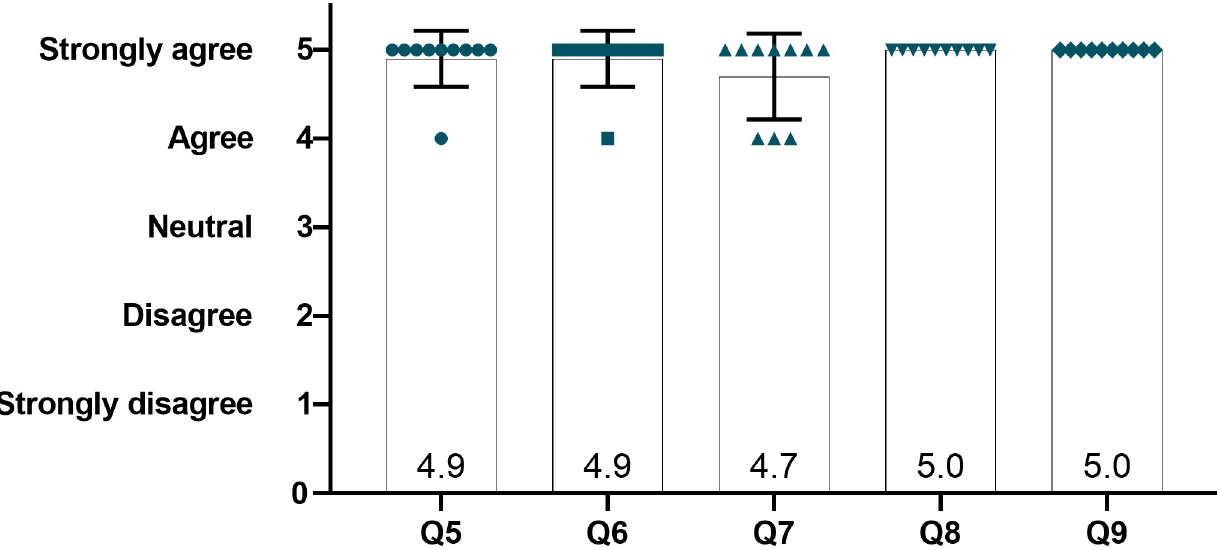
Fig 7. Surgeons assessment of appropriateness for educational use. Q5: Are these models appropriate and useful for surgery training? Q6: Are these models good alternatives to cadaveric skulls for training purposes? Q7: Would these models help trainees to develop their confidence? Q8: Would you use these models to train someone or to be trained on new techniques? Q9: Would you use these models to test the feasibility of new surgeries? Data presented with mean and SD.